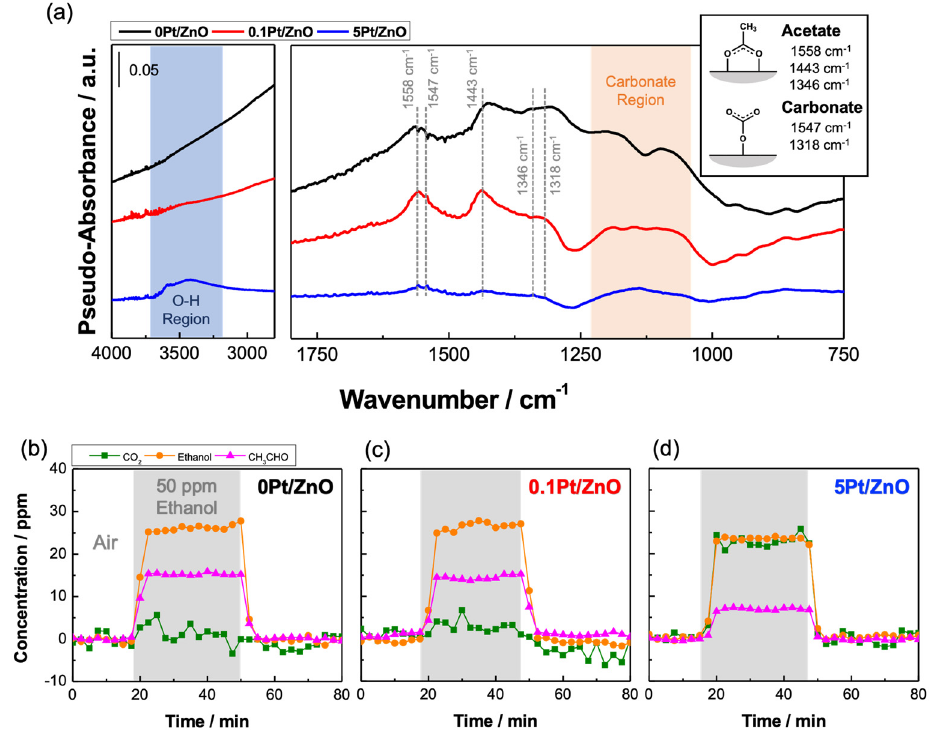
Figure 7. ( a ) DRIFT spectra of 0Pt/ZnO, 0.1Pt/ZnO, and 5Pt/ZnO NCs recorded after exposure to 50 ppm ethanol in dry synthetic air at 350 °C. Time dependence of the concentration of gaseous products formed by the combustion of ethanol on ( b ) 0Pt/ZnO, ( c ) 0.1Pt/ZnO, and ( d ) 5Pt/ZnO NCs at 350 °C.